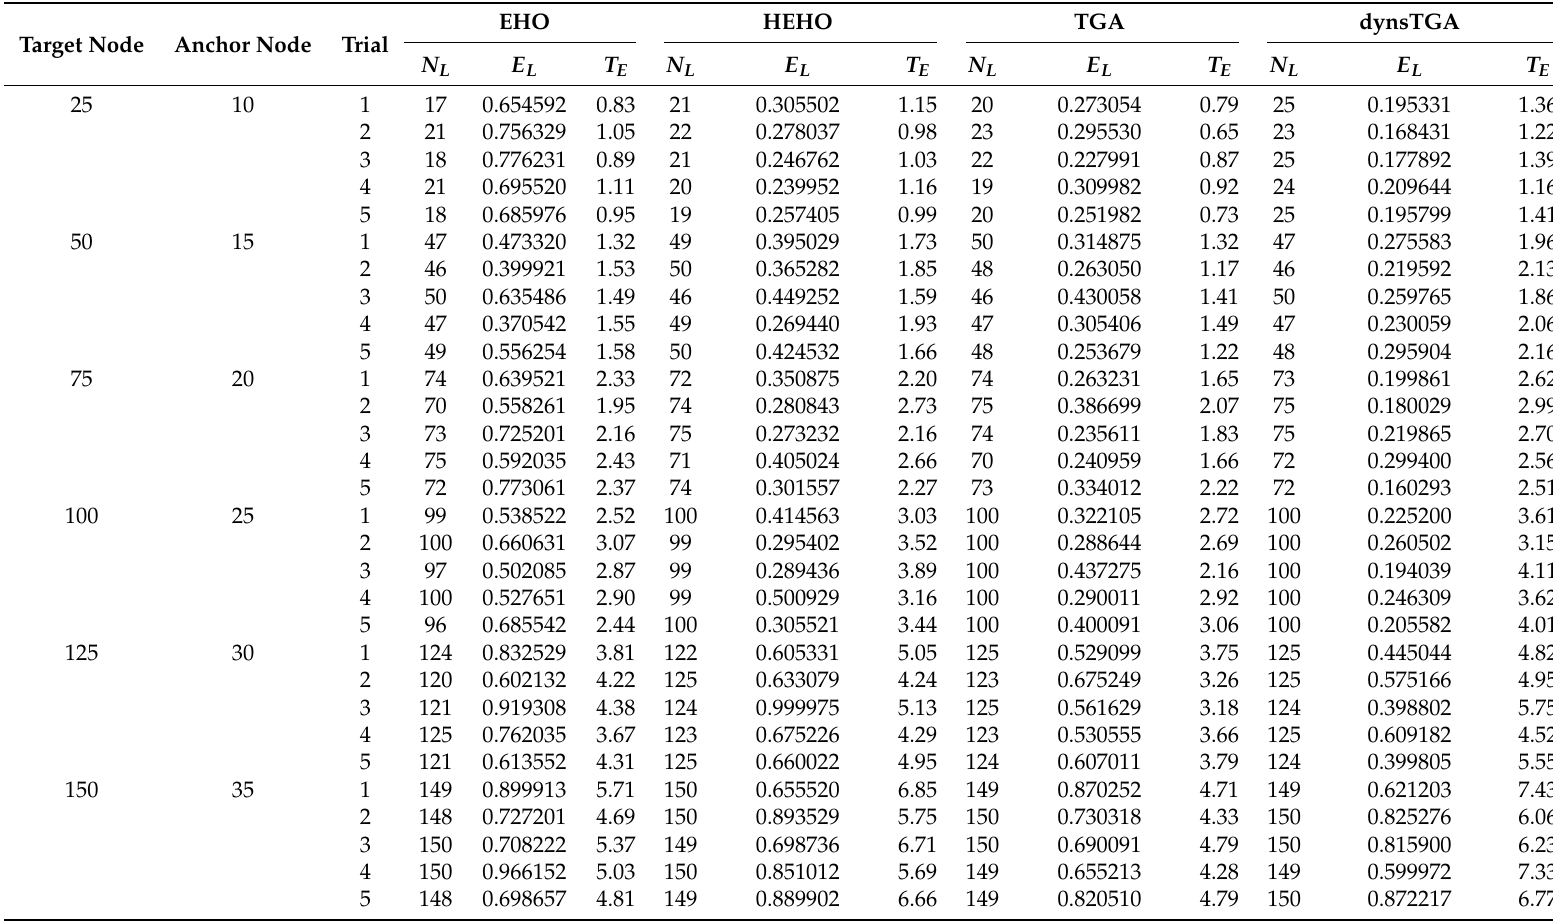
Table 7. Detailed results of EHO, HEHO, TGA, and dynsTGA proposed localization ( N L = number of localized nodes, E L = localization error, T E = execution time in